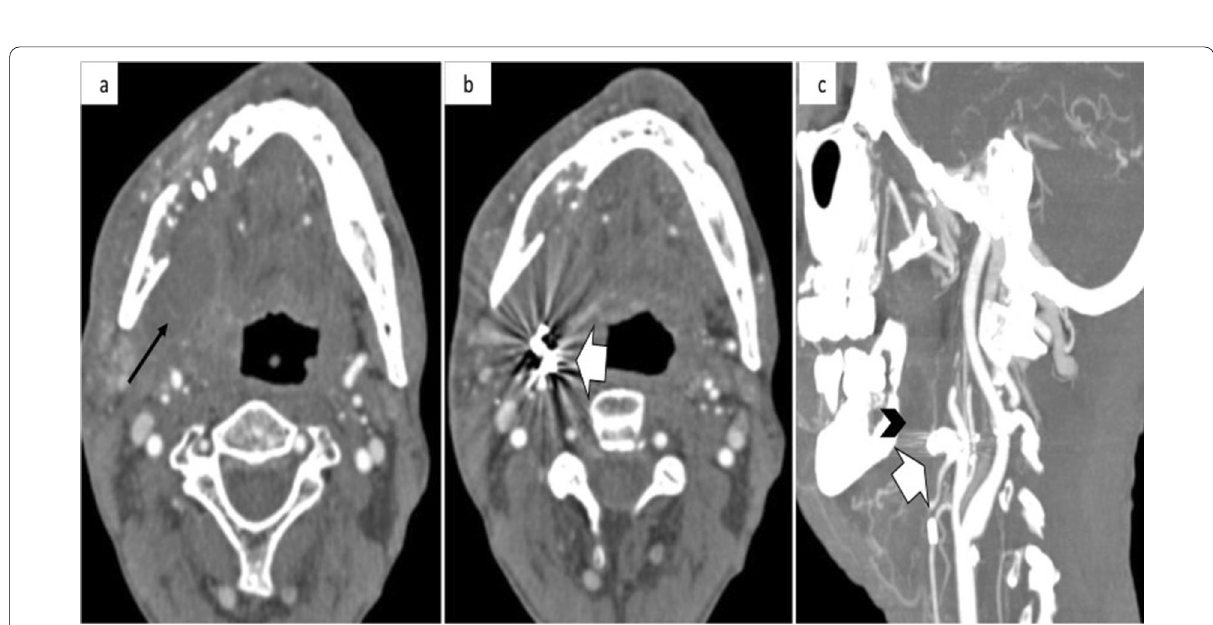
Fig. 3 Post-procedure computed tomography of face; eight days after embolization of case 1. a Axial section demonstrates non-opacification of the pseudoaneurysm (indicating successful embolization (arrow). b Axial section shows the presence of microcoils (open arrow). c Sagittal section MIP image shows a thrombosed aneurysm (arrowhead) and patent rest of arteries except facial artery (open